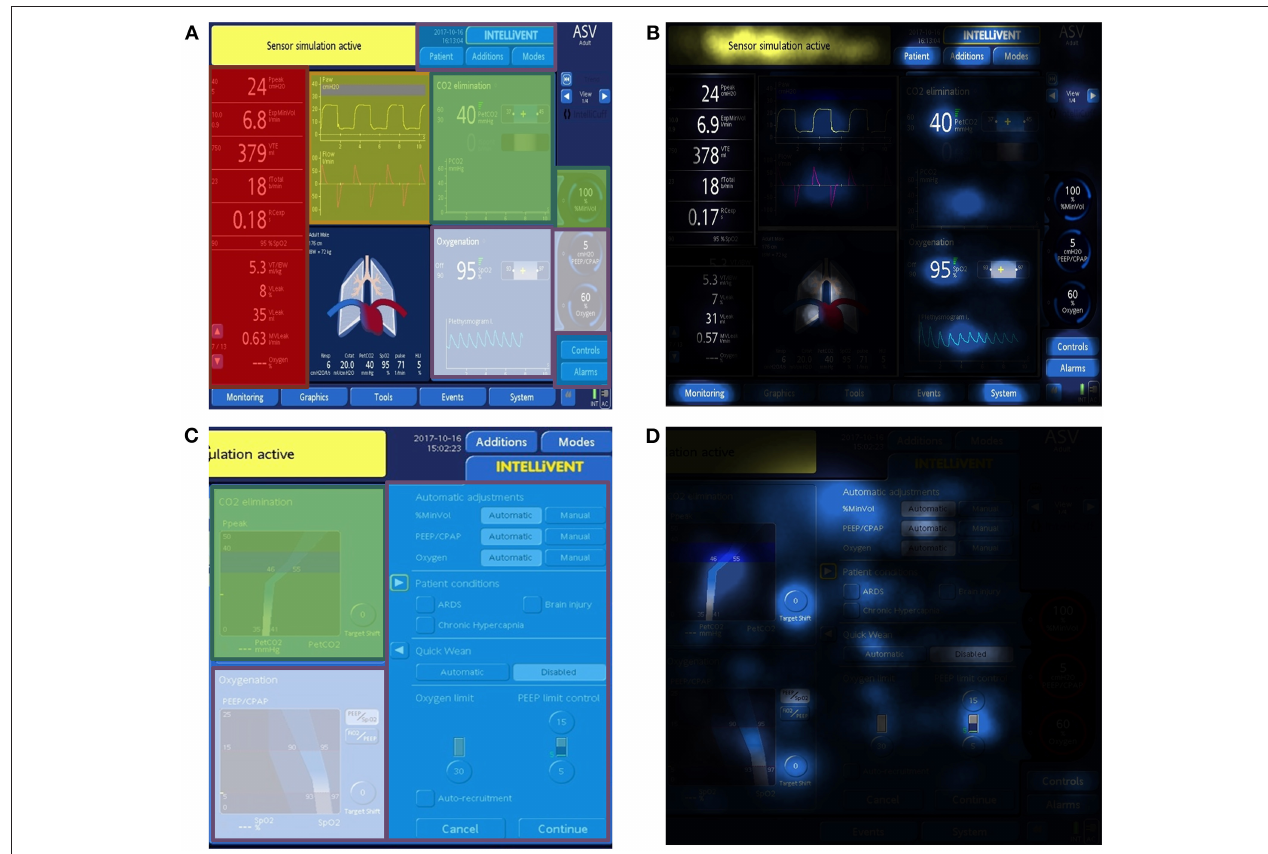
FIGURE 1 | Sample screen panels of the Hamilton Medical S1 respirator in closed-loop ventilation mode. The AOIs settings (blue), ventilation curves (yellow), numeric values (red), oxygenation Intellivent (white) and ventilation Intellivent (green) were pre-defined. The AOIs and the standard display of the screen are visualized in (A,C) . (B,D) depict the integrated focus maps for dwell time of all participants. In focus maps, more/longer fixations lead to a brighter color. Darker areas indicate fewer fixations.